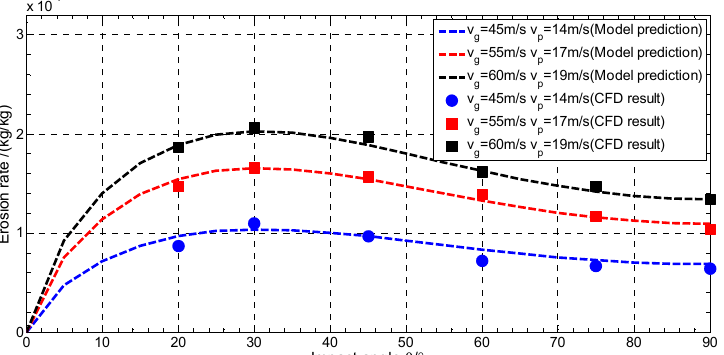
Figure 14. A comparison between the simulation and erosion models of the Q235 carbon steel specimen ( v g = ~45–60 m/s, v p = ~14–19 m/s, d p = 300 μ m, and θ = ~20°–90°).